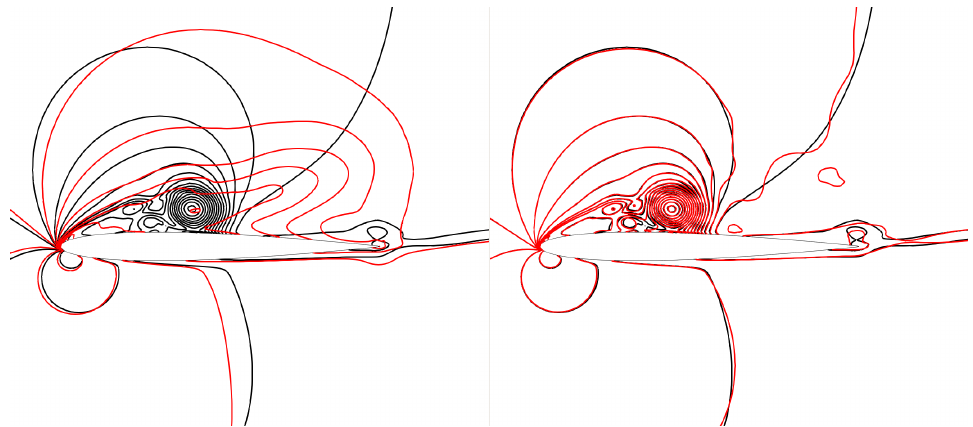
Figure 3. Volume reconstruction of density at time t = 0.06 s for 2 modes ( left ) and 28 modes ( right ), NACA0009 test case. Black contours represent the CFD reference solution; red contours represent the ROM reconstructed solution.